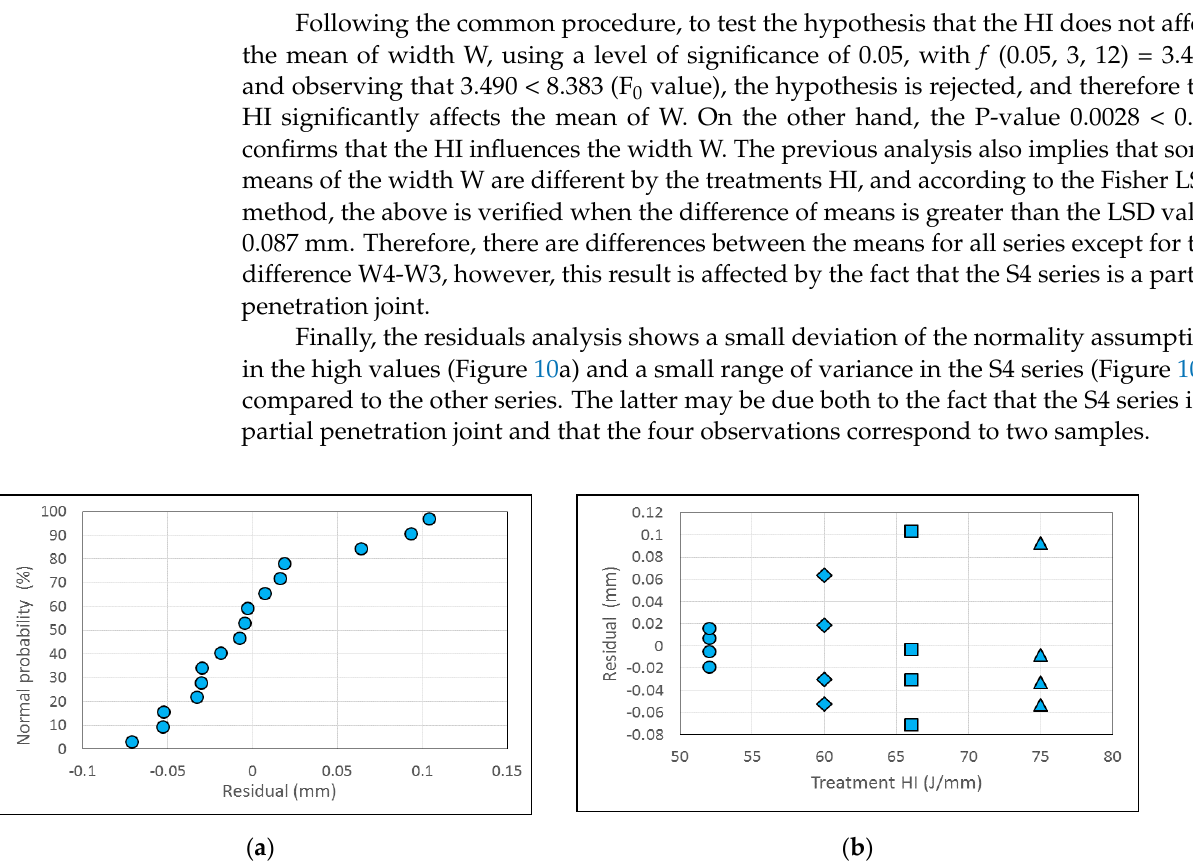
Table 11. ANOVA table for factorial design applied to width W.